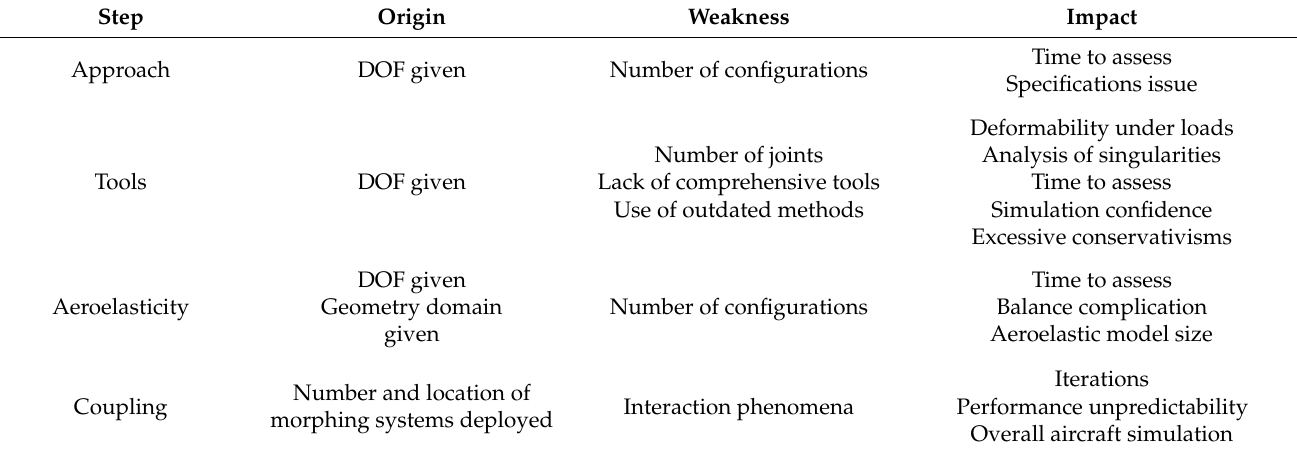
Table 2. Summary of weakness and criticalities of a morphing